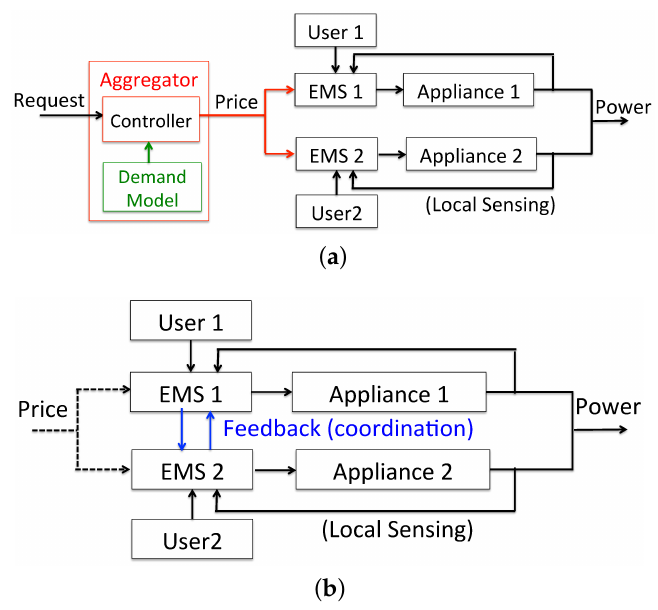
Figure 2. Control schemes. Example for two users, each one consisting of an energy management system (EMS) controlling a single appliance. ( a ) A feed-forward control is realized, with all users responding to the same price signal; ( b ) A feedback control is realized through the coordination (communication) among